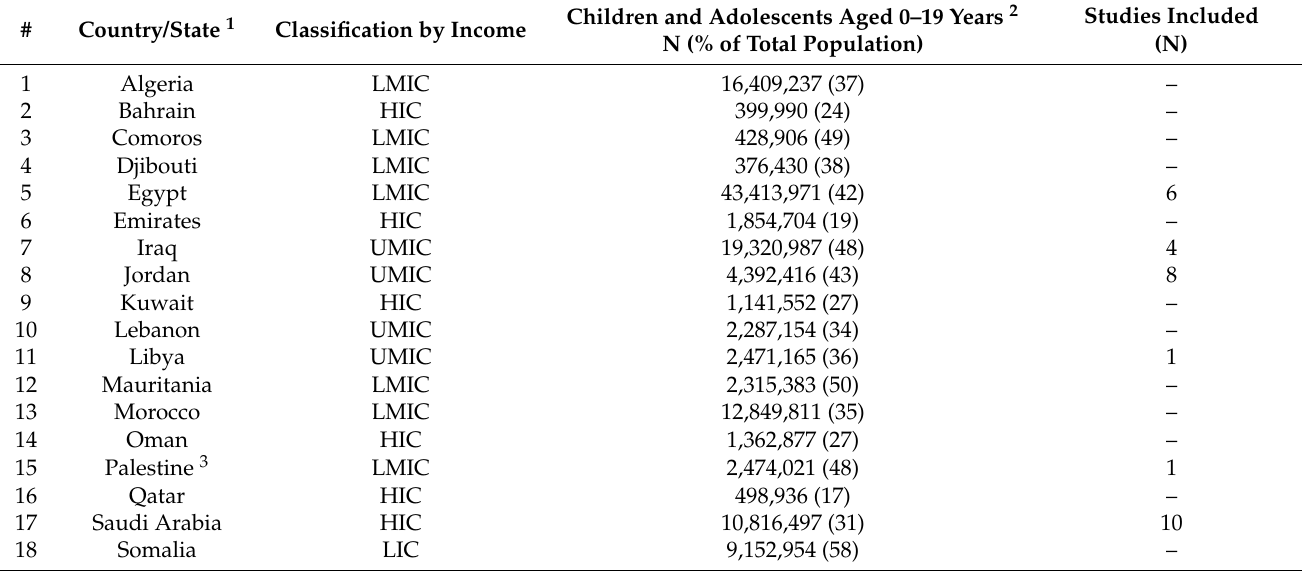
Table 1. Eligible publications per country included in this review. The table also shows the classifica- tion of ASCs by income and child population of each